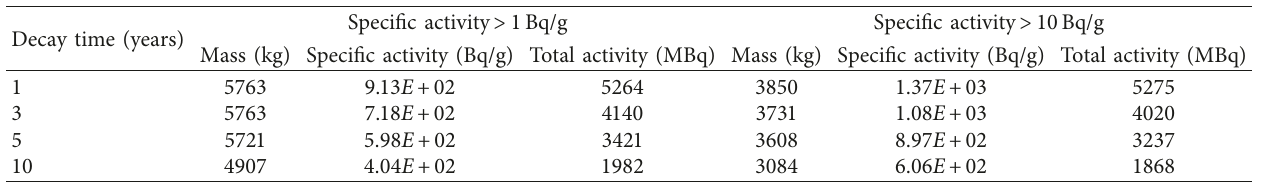
Table 7: Activity of graphite in the thermal and thermalizing columns.